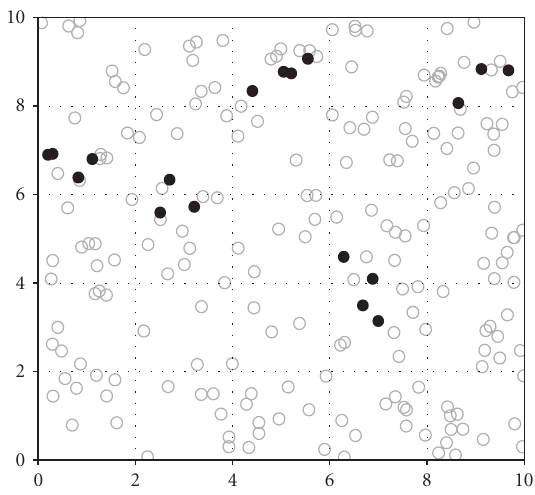
Figure 1: Aggregates, Point map. Grey circles are drawn from a homogenous Poisson process. Black disks are generated by a Mat´ern (radius = 0.5)